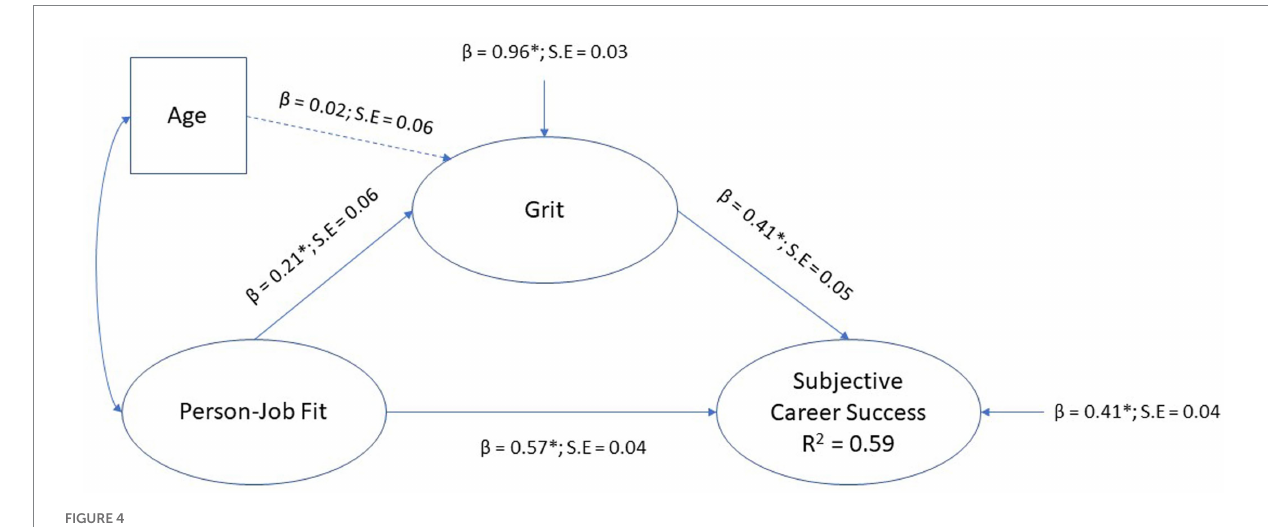
FIGURE 4 Mediation model for